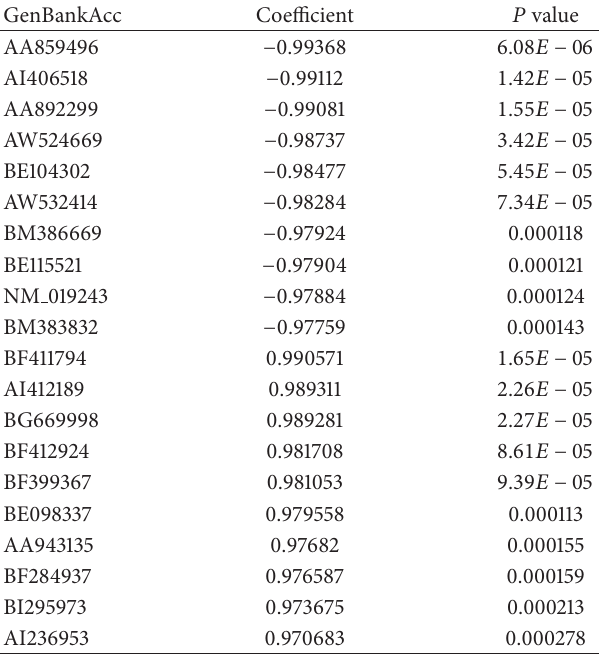
Table 5: The most significant negative and positive correlation between gene expression level and fracture time at 𝑃 value < 0.005 (top 10 of